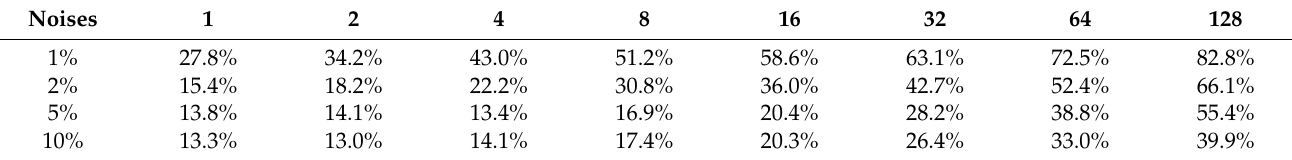
Table 7. Detection results of the EfficientNetB0 within the background with connected